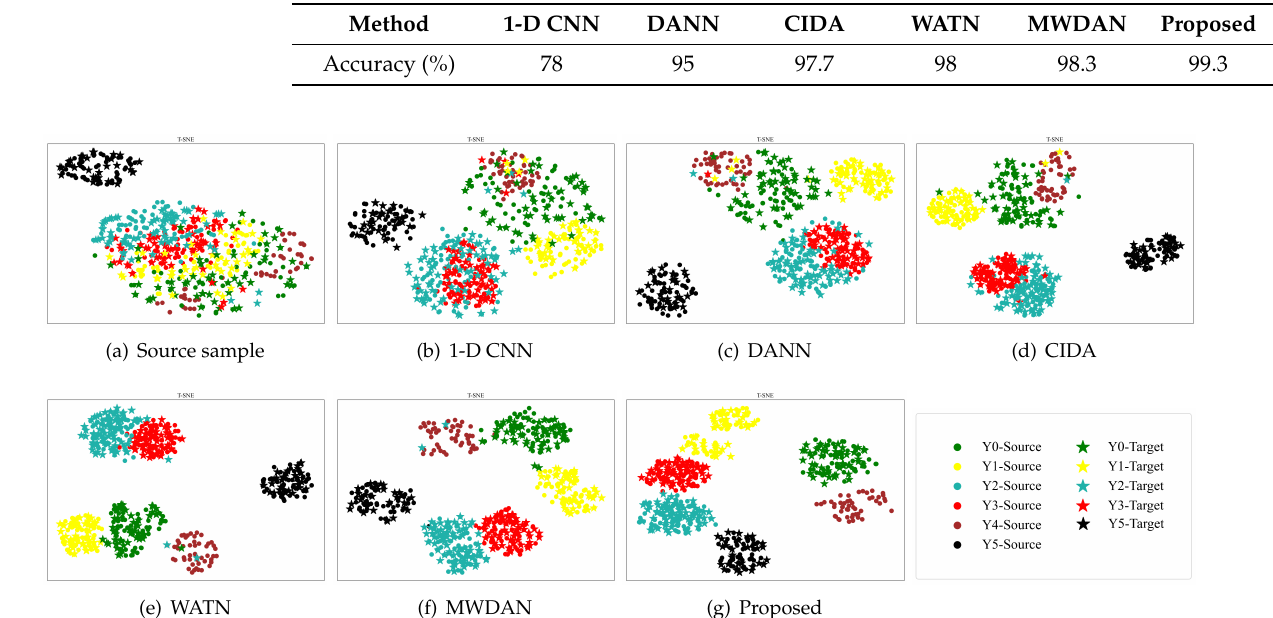
Table 2. Diagnosis results with different methods.